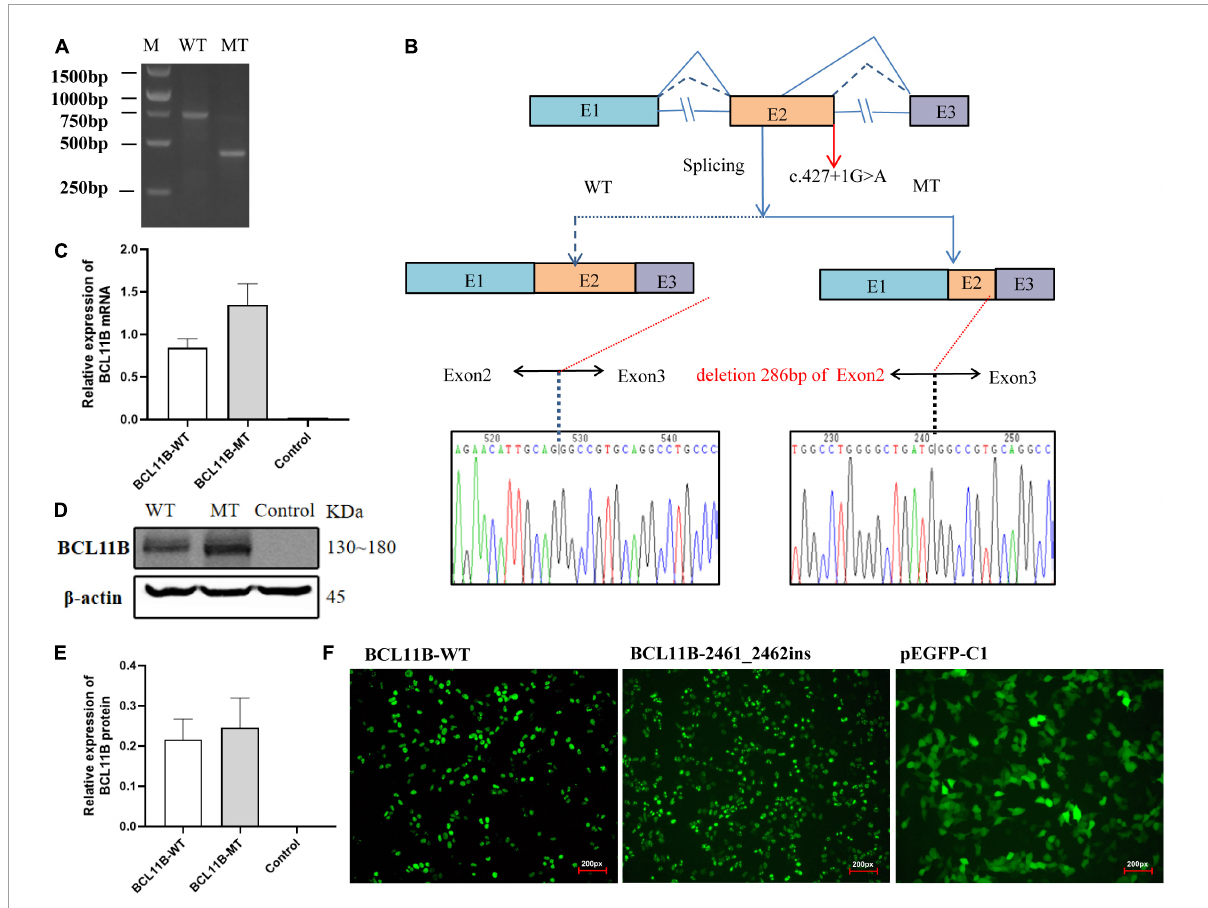
FIGURE3 The in vitro minigene assay of the c.427 + 1G > A variant and the overexpression assay of the c.2461_2462insGAGCCACACCGGCG variant in HEK293T cells. (A) The identification of a shorter transcript with 286 bp deletion of the Exon 2 downstream, attributing to the activation of a novel cryptic 5 (cid:48) donor splice site in Exon 2. (B) A schematic diagram of the abnormal splice and Sanger sequencing of cDNA from transfected cells. (C) Quantitative analysis of mRNA expression of WT and frameshift mutant plasmids. (D) Western blot analysis of WT and frameshift mutant protein. (E) Quantitative analysis of protein expression of WT and frameshift mutant plasmids. (F) Fluorescent image (200px) of wild-type and mutant BCL11B-EGFP in HEK293T cells. Both wild-type and mutant types could be expressed, and there was no significant change in cell morphology and localization. M, DNA marker; WT, wild type; MT, mutant